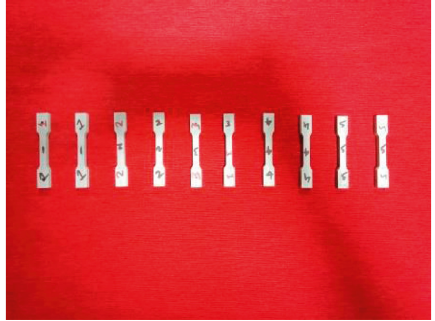
Figure 4: Test samples for tensile strength analysis.